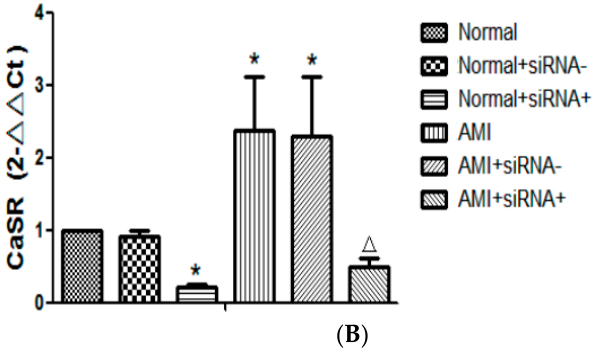
Figure 3. Silence effect of CaSR small interfering RNA (siRNA) transfection. T lymphocytes were transfected with 5 μ g positive plasmid or negative plasmid. Protein or mRNA was harvested 24 h post-transfection. Western blot ( A ) and qRT-PCR ( B ) results showed that the positive CaSR siRNA plasmid transfection in T lymphocytes reduced the expressions of CaSR mRNA and protein, which increased remarkably in AMI patients. In addition, negative plasmid of CaSR siRNA had no effect on the CaSR expression. * p < 0.05 vs. normal group; Δ p < 0.05 vs. AMI group.